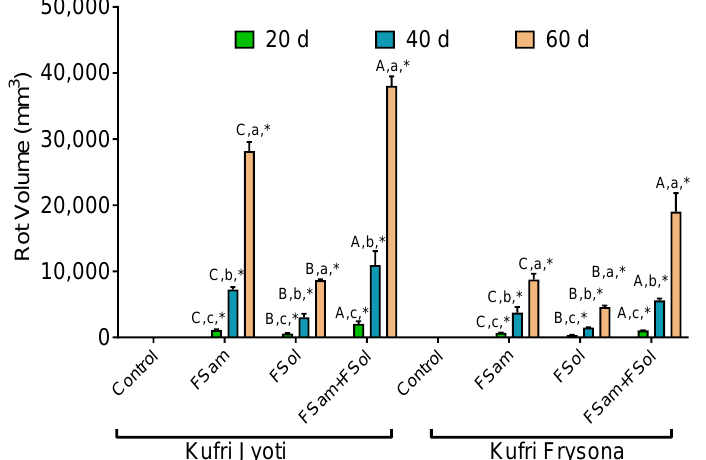
Figure 4. Effect of dry rot infection on rot volume after 0, 20, 40, and 60 d of infection. Scale in the figure denotes rot volume expressed in mm 3 . Control, no pathogen infection; FSam, Fusarium sam- bucinum ; FSol, Fusarium solani ; FSam + FSol, Fusarium sambucinum + Fusarium solani . Capital letter